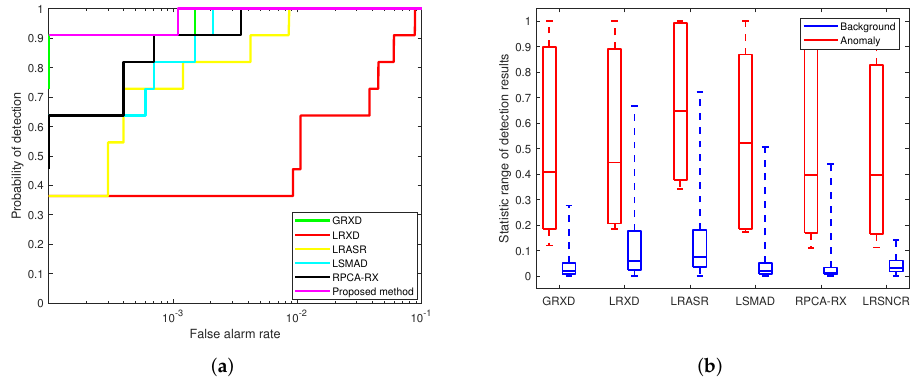
Figure 20. ROC curves and separability map acquired through the ABU-urban dataset. ( a ) ROC curves. ( b ) Box-plot.